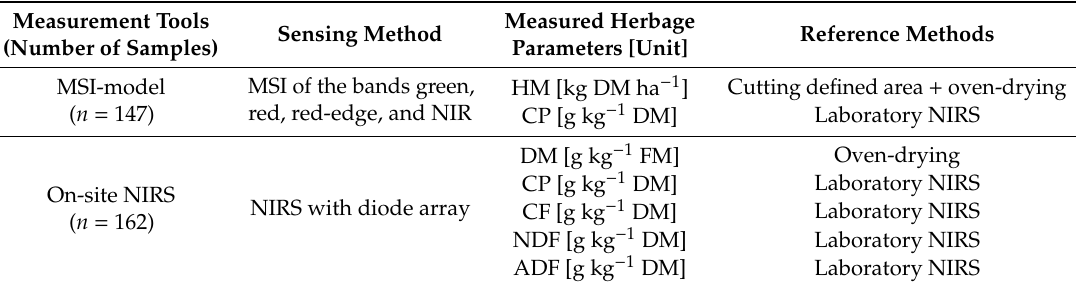
Table 1. Evaluated smart farming tools and determined herbage parameters with the respective reference methods.